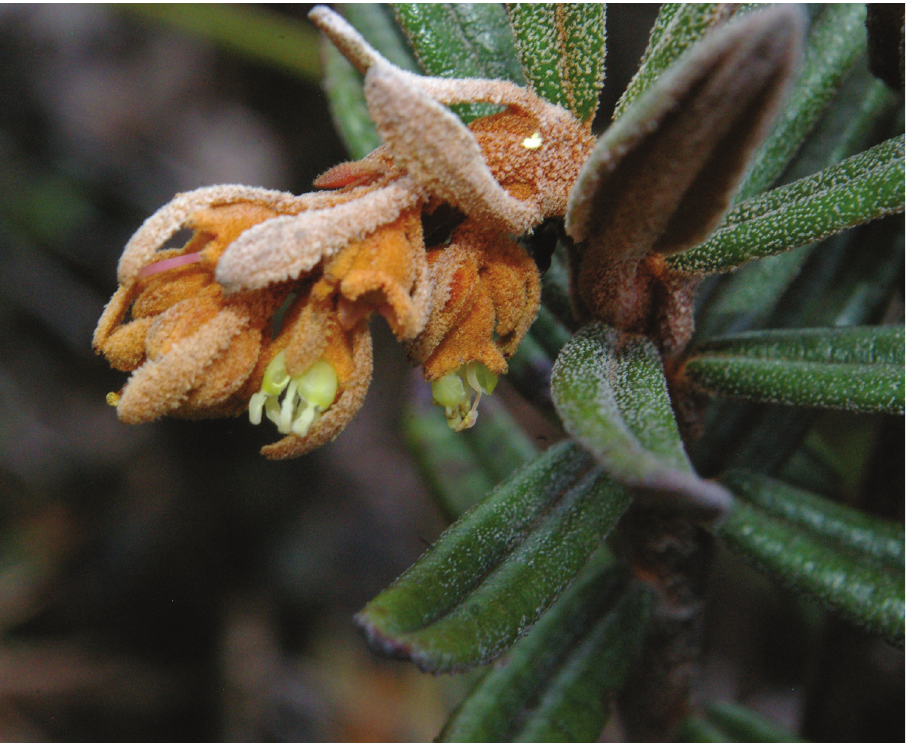
Figure 3. Miconia machinazana, flowering branch, Neill 16909 (photograph D.A.